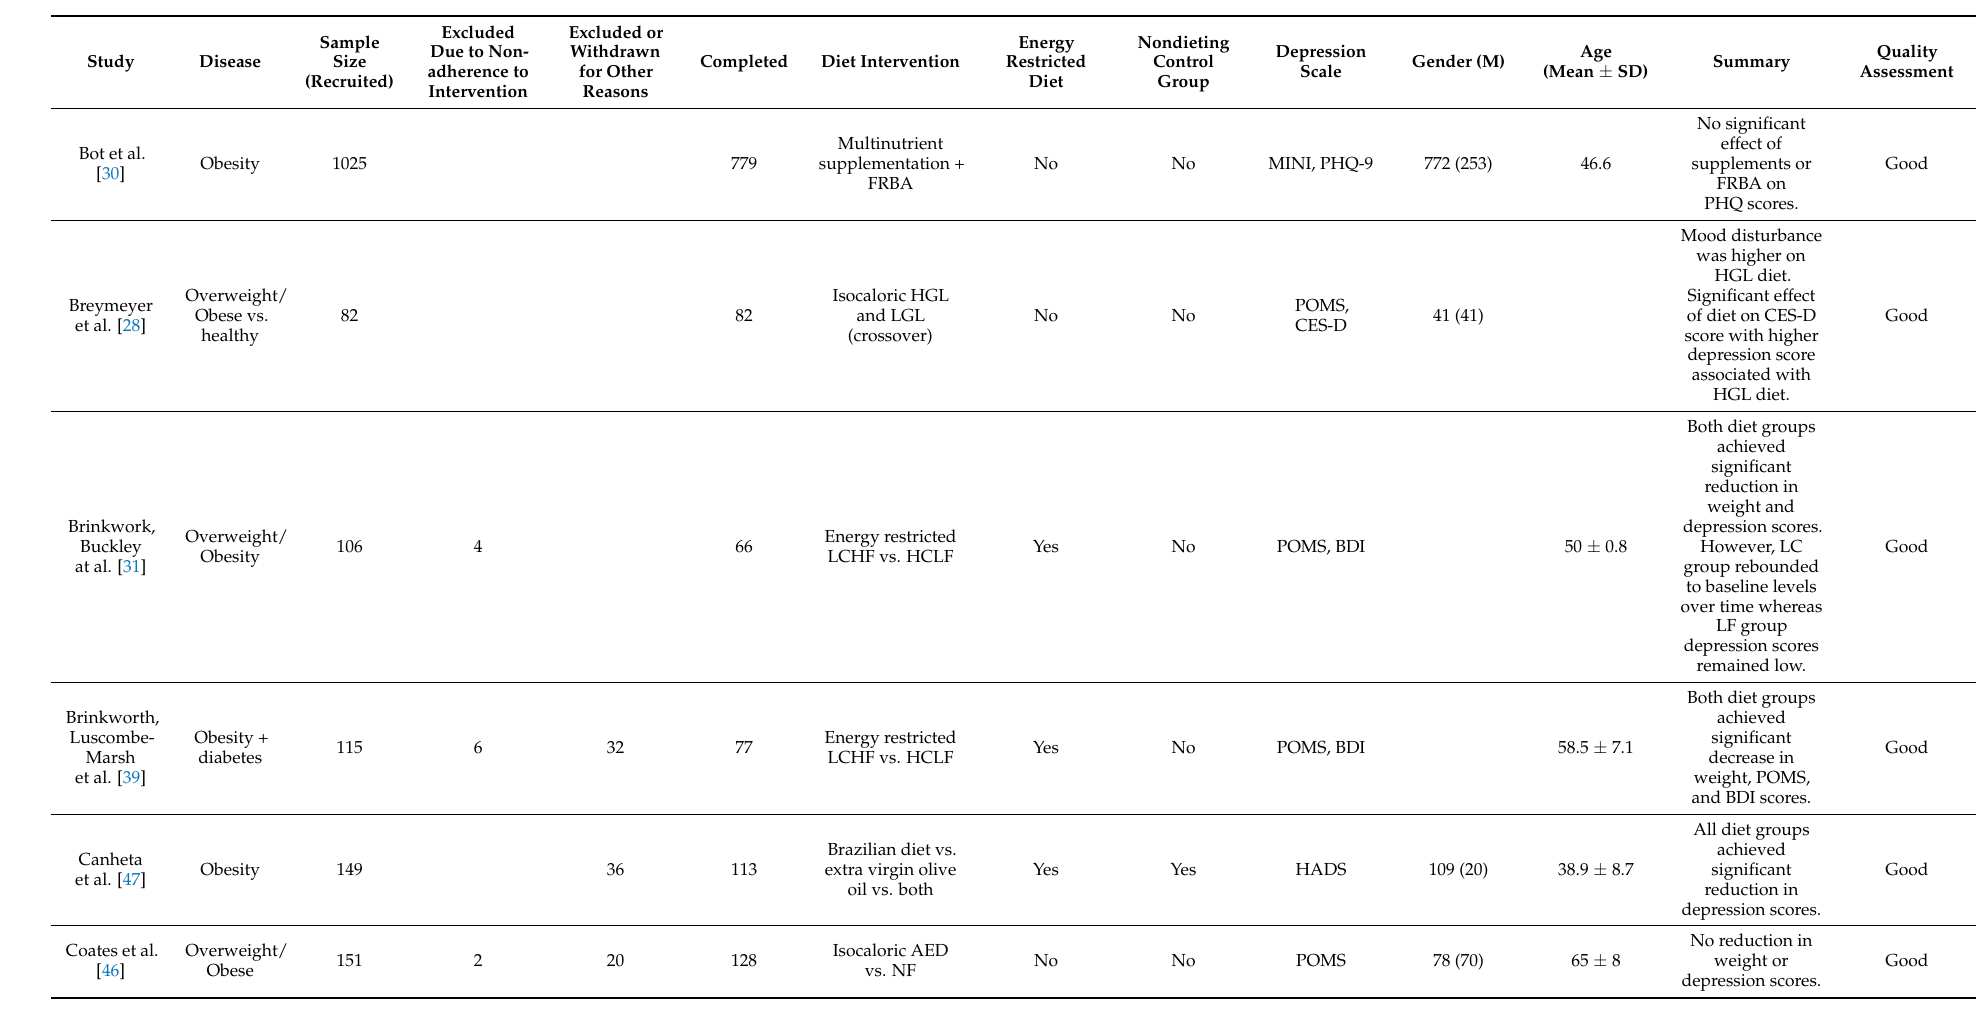
Table 1. Characteristics of included